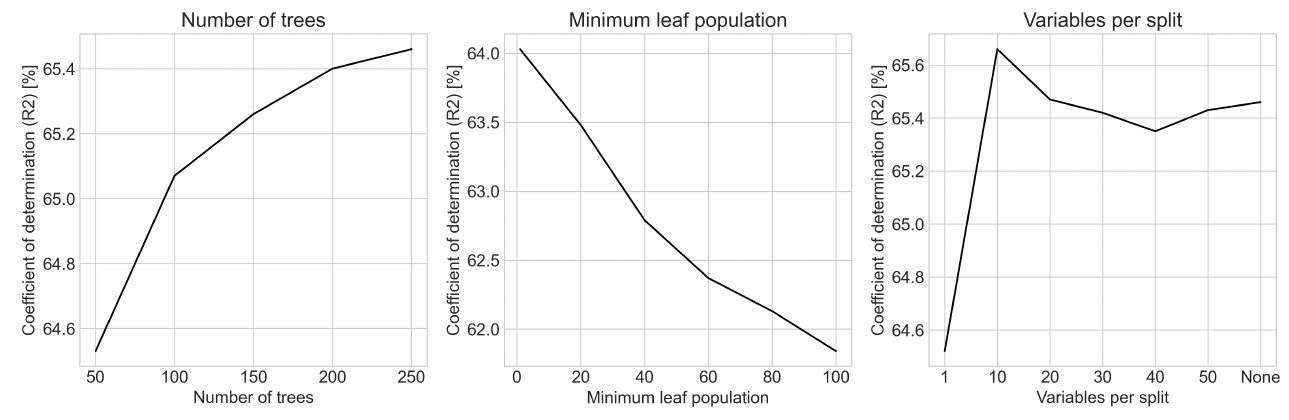
Figure A4. Sensitivity analysis for the 2022 canopy height model highlighting increased model accuracy when specifying a high number of trees, low minimum leaf population and a rather low number of variables per